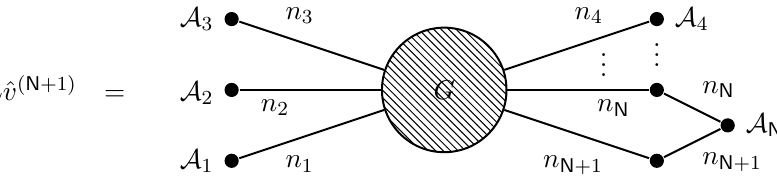
Figure 2 . The graph representation of the entropy vector ^ v ( N +1)